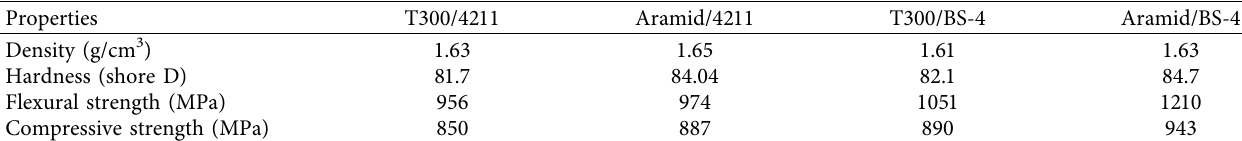
Figure 3: Morphologies of the four composites: (a) T300/4211. (b) Aramid/4211. (c) T300/BS-4. (d) Aramid/BS-4. Table 1: Physical and mechanical properties of composites